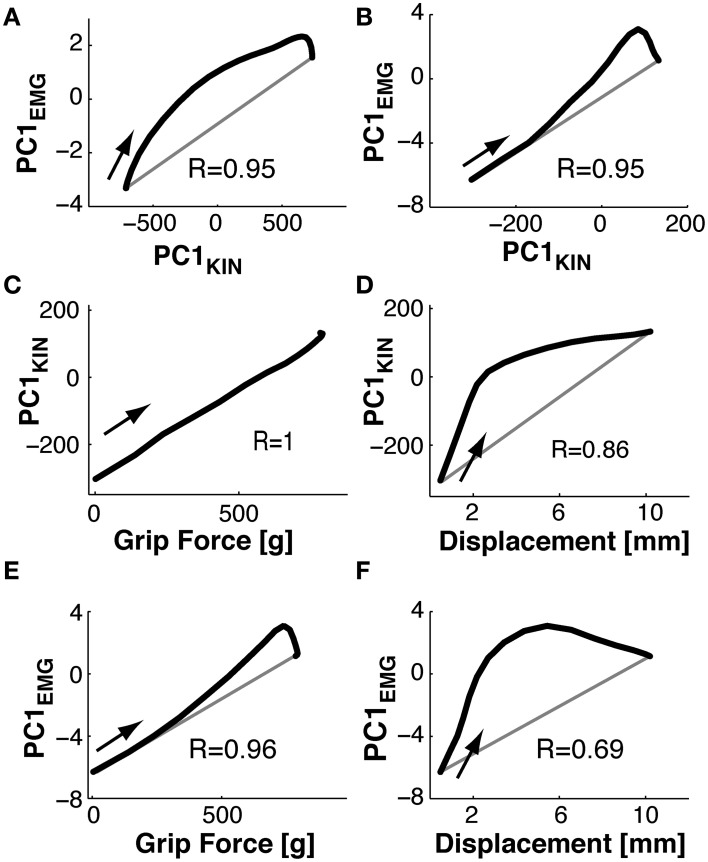
Phase plane plots. (A,B) Functional link between muscle and kinematic synergies. (C,D) Functional link between kinematic synergies and grip force or displacement during Grasp&pull. (E,F) Functional link between EMG synergies and grip force or displacement during Grasp&pull. (A) During Reach: phase plane of the PC1 temporal weighting in the EMG-space against the PC1 temporal weighting in the kinematics-space i.e., PC1(t)EMGvs.PC1(t)KIN. Note the phase advance of PC1(t)EMG (above the gray diagonal between the start and end point) againstPC1(t)KIN. (B) During Grasp&pull: phase plane of PC1(t)EMGvs.PC1(t)KIN. Note progressive phase advance of PC1(t)EMG.(C) Phase plane PC1(t)KINvs.grip force. Note perfect correlation, no time lag. (D) Phase plane PC1(t)KINvs.displacement, showing loose coupling and strong phase advance of PC1(t)KIN with displacement. (E) Phase plane PC1(t)EMGvs.grip force, with strong correlation and increasing phase advance of PC1(t)EMG. (F) Phase plane PC1(t)EMGvs.displacement, with loos coupling and strong phase advance of PC1(t)EMG with displacement. The arrow in each graph indicates the temporal direction (start) of the phase-plane trajectory.